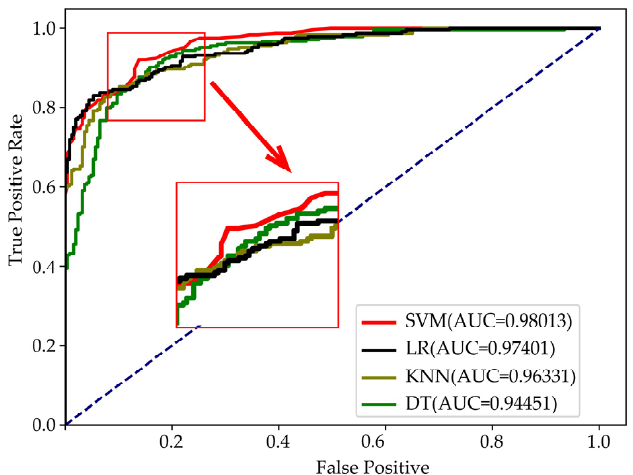
Figure 8. The ROC curve of stacking structures under different meta-models.